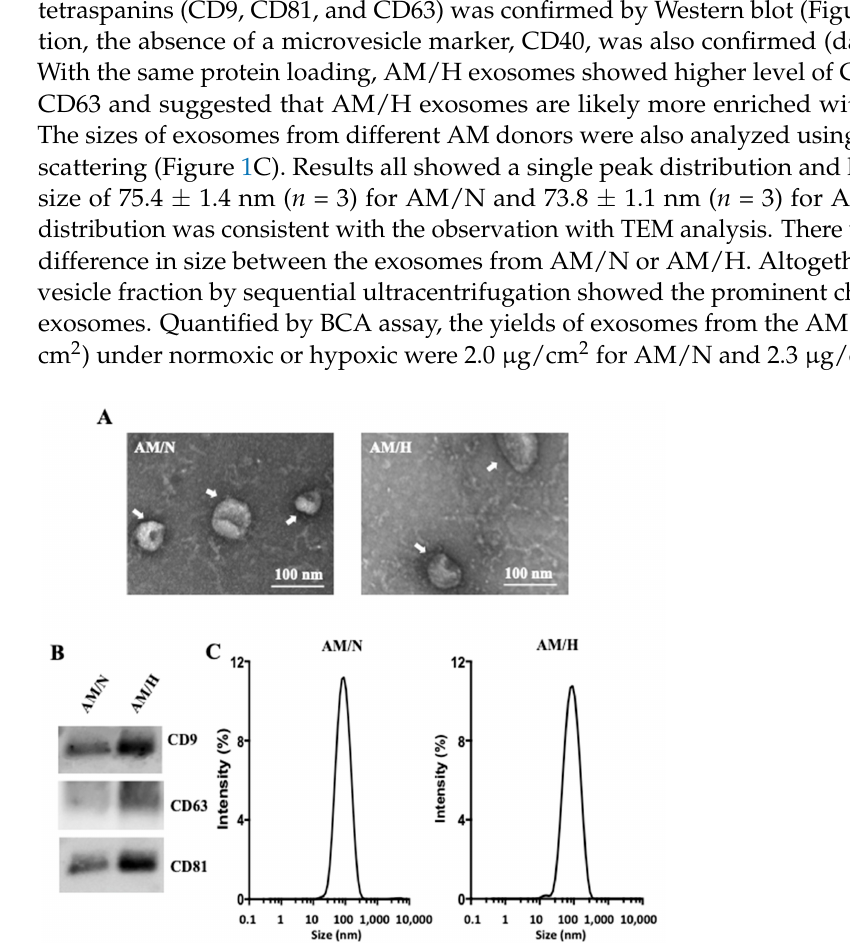
Figure 1. Characterization of exosomes isolated from amniotic membrane (AM). Exosomes were isolated from conditioned media prepared from AM under normoxic (AM/N) or hypoxic (AM/H) conditions as described in the Methods. Exosomes were examined by transmission electron microscopy ( A ). Representative exosomes are indicated by white arrows. Scale bar = 100 nm. The presence of tetraspanins in exosomes was determined by SDS-PAGE followed by Western blot using antibodies against human CD9, CD63, and CD81 ( B ). The particle size of exosomes was analyzed using dynamic light scattering. The size distributions were graphed against the percentage of intensity ( C ).